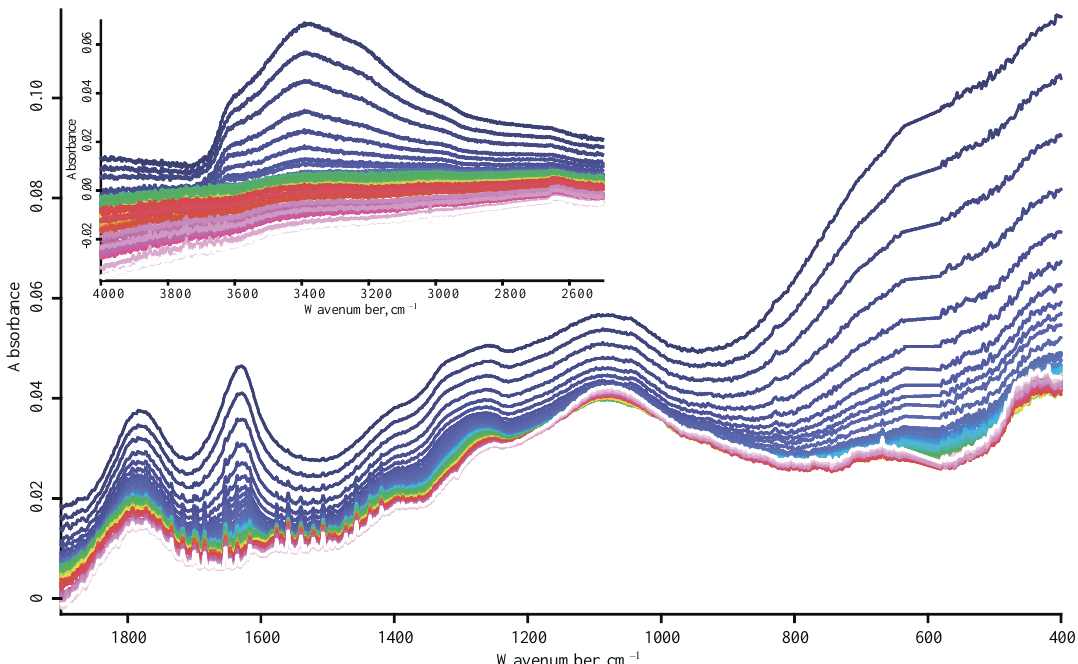
Figure 7. ATR mode, SDND nanodiamonds, heating from 25 °C (blue) to 215 °C (pink). Spectra are not smoothed.